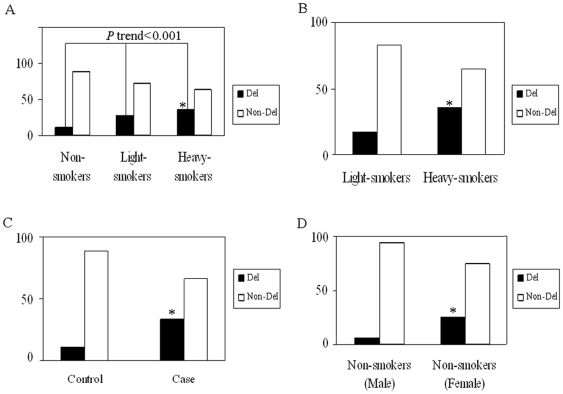
Distribution of the 822 bp mtDNA deletion among cases and controls.Del, deletion. The median number of pack-years of combined cases and controls was utilized as the cut-point to stratify the cigarette smoking subjects. The single bar depicting the proportion of individuals who had the deletion or not. * indicating p<0.001. (A) Distribution of the mtDNA deletion among subjects pooled from cases and controls and stratified by pack-years of cigarette smoking. Non-smokers who had no any history of cigarette smoking; Light-smokers who smoked 1–30 pack-years of smoking; Heavy-smokers who smoked >30 pack-years of smoking; p trend was calculated by the chi-square test for linear-by-linear association (both p value and p trend <0.001). (B) Distribution of the mtDNA deletion among light-cigarette and heavy-cigarette smoking subjects of combined cases and controls. Light-smokers who smoked 0–30 pack-years of smoking; Heavy-smokers who smoked >30 pack-years of smoking. ORs (95% CIs) and p value determined by multivariate logistic regression analysis, adjusted for age and gender (OR = 6.540, 95% CI = 3.247–13.174, adjusted p value<0.001). (C) Distribution of the mtDNA deletion among cases and controls. Compared with controls, the mtDNA deletion was significantly enriched in cases of lung cancer (p<0.001). ORs (95% CIs) and p value determined by multivariate logistic regression analysis with adjustment for age, gender and smoking habits (OR = 3.776, 95% CI = 2.662–5.355, adjusted p<0.001). (D) Distribution of the mtDNA deletion among non-cigarette smoking subjects pooled from cases and controls and stratified by gender. Non-smokers who had no any history of cigarette smoking. ORs (95% CIs) and p value determined by multivariate logistic regression analysis adjusted for age (OR = 5.814, 95% CI = 3.279–10.309, adjusted p<0.001).